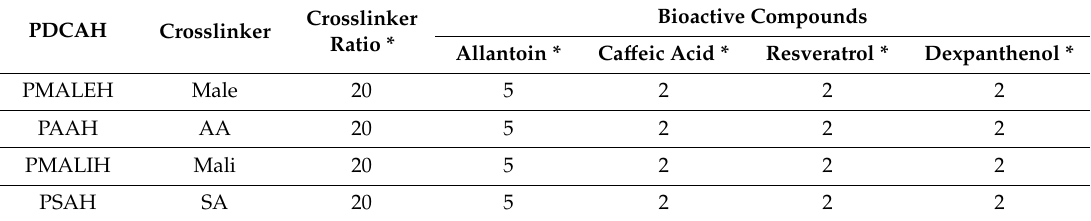
Table 1. Specifications of supramolecular PDCAH and amount of BC loading. Bioactive Compounds Crosslinker PDCAH Crosslinker Ratio * Allantoin * Ca ff eic Acid * Resveratrol